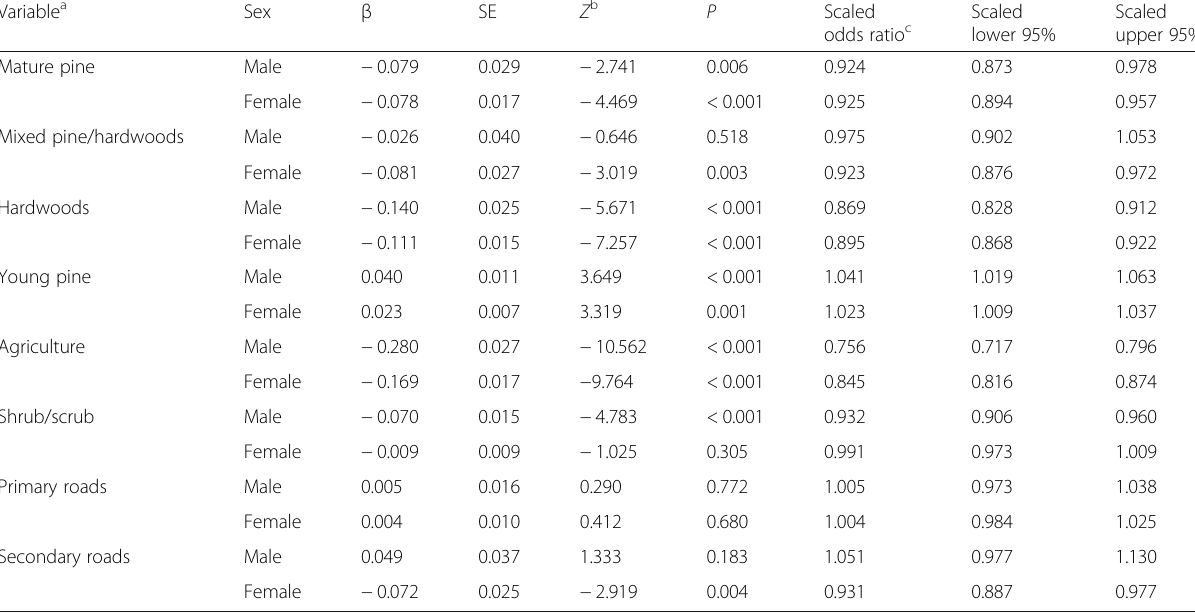
Table 3 Parameter estimates for bobcat habitat selection at the annual area of use spatial scale Variable a Sex Mature pine Mixed pine/hardwoods Male